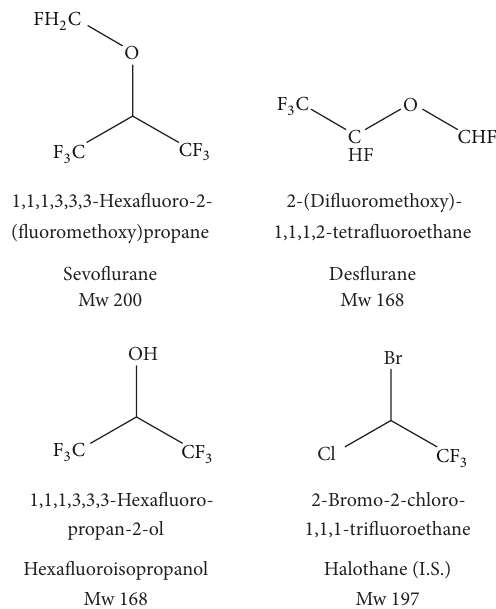
Figure 1: Structures of halogenated anesthetics determined sevoflu- rane and desflurane, of sevoflurane’s metabolite hexafluoroisopropyl alcohol, and of halothane (internal standard).